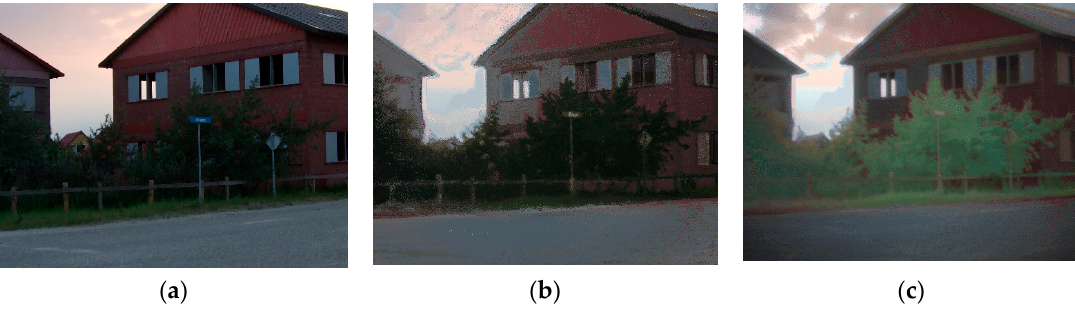
Figure 2. ( a ) Daytime reference image; ( b ) Intermediate (result at step 5); and ( c ) final result (after step 6) of the color-the-night (CTN) fusion method, in which the luminance is determined by the input sensor values (rather than by the corresponding daytime reference).